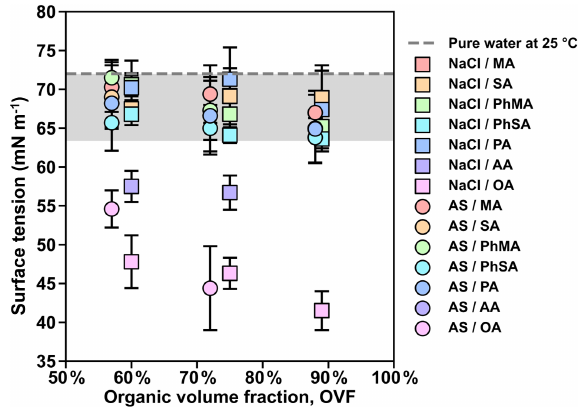
Figure 6. Measured surface tension values of inorganic salt and dicarboxylic acid particles under RH over 99.5%. The gray area covers the surface tension reductions of below 12% compared with pure water (72mNm − 1